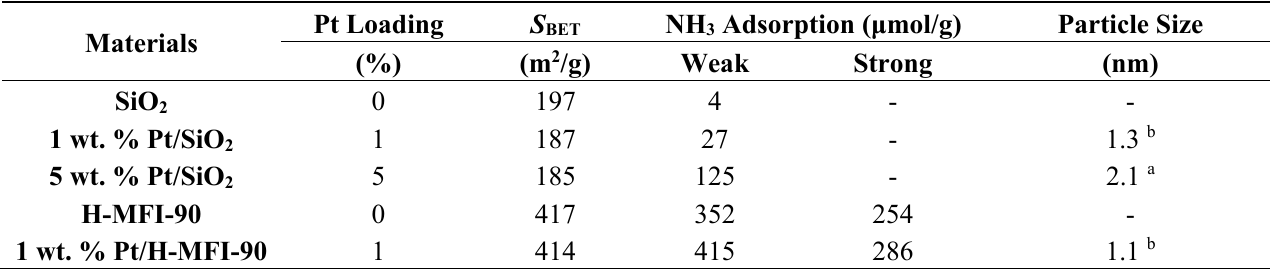
Table 1. Textural properties of the supports and the prepared catalysts (for details on XRD analysis and ammonia adsorption, cf. Figures S1 and S2 in the electronic support information, respectively).